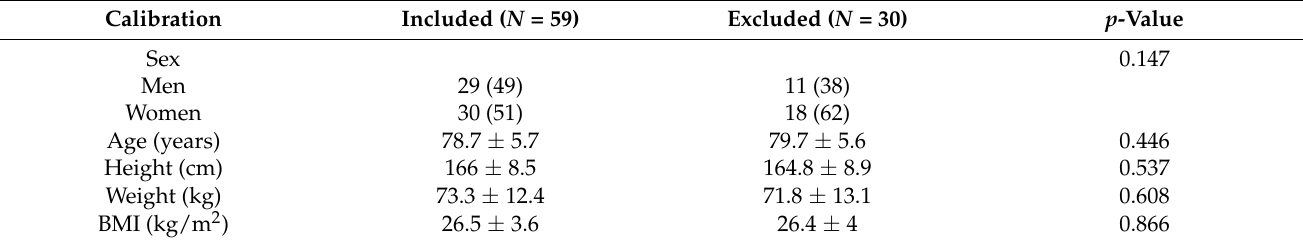
Table A1. Descriptive characteristics of participants included and excluded in the AREA